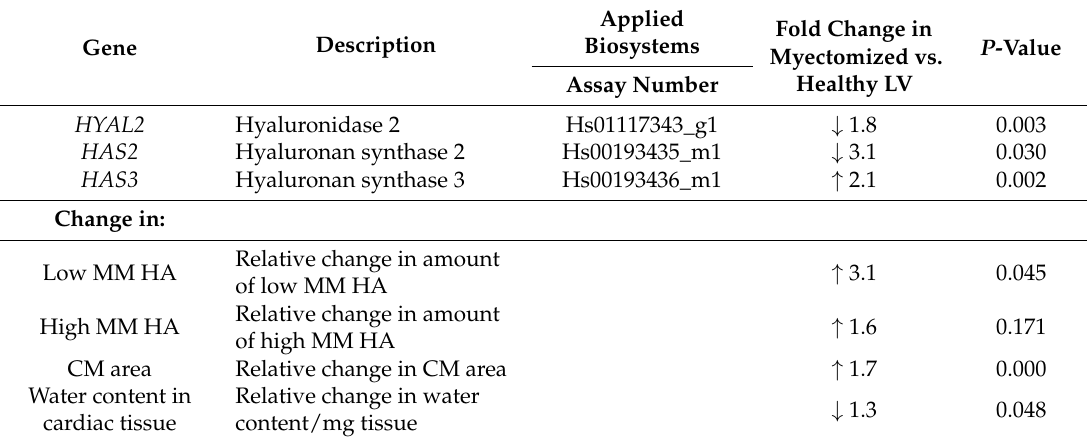
of low MM HA Relative change in amount of high MM HA CM area Relative change in CM area 0.000 Water content in Relative change in water cardiac tissue content/mg tissue